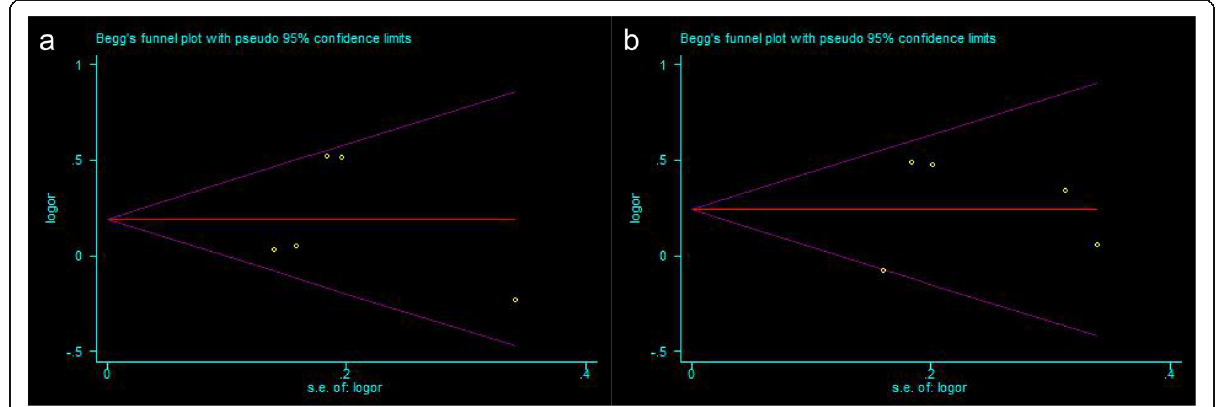
Fig. 3 Begg ’ s funnel plot of the VDR polymorphisms and PCOS in the Asian population. a VDR ApaI (rs7975232) with allelic model: C vs. A; b VDR BsmI (rs1544410) with allelic model: G vs. A